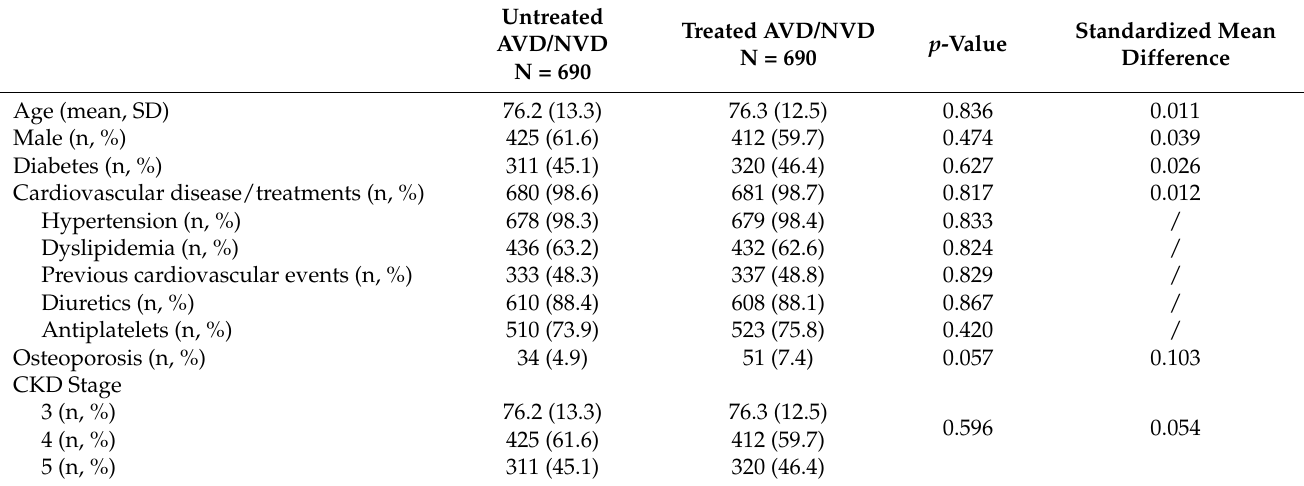
Table 2. Baseline demographic and clinical characteristics of patients CKD + sHPT treated and untreated with AVD/NVD, post PSM.